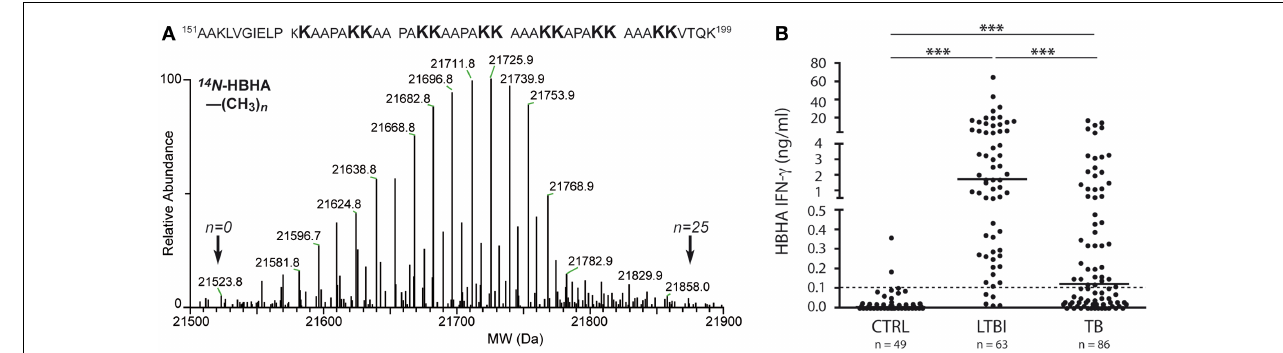
stimulation according to Mtb infection status. Shown are IFN γ concentrations in nanogram/milliter as measured in Elisa after stimulation with methylated HBHA for 24h of PBMC from three groups of subjects: non-infected controls (CTRL), subjects with latent Mtb infection (LTBI), and patients with active tuberculosis (TB).The dotted line represents the positivity cut-off for the assay. For each group, the median of results is marked as a horizontal line. Statistical significance of differences: *** p ≤ 0.0001. Data are with licensed permission from Ref.